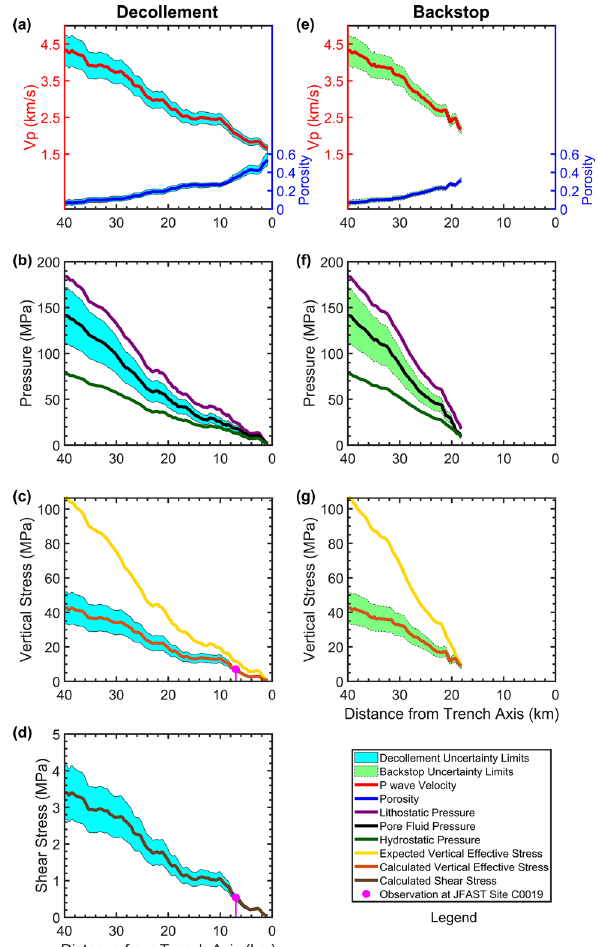
Figure 3. Physical properties calculated for the decollement (left column) and backstop interface (right column). ( a , e ) P-wave velocity (red line) extracted at the corresponding horizon depth and the associated porosity values (blue line) transformed by an empirical relationship (“Methods” section). ( b , f ) Lithostatic (purple line), hydrostatic (dark green line), and pore-fluid (black line) pressure values. ( c , g ) Calculated vertical effective stress (maroon line) and expected vertical effective stress under normal consolidation conditions (yellow line). ( d ) Shear stress calculated at decollement level. The magenta filled circles in panels ( c ) and ( d ) mark the previous borehole observation results 7,8 from JFAST site C0019. The uncertainty bands indicated in cyan (for decollement) and light green (for backstop) include the cumulative errors of velocity to porosity transformation, consolidation curve fitting, and V p inaccuracies (“Methods”